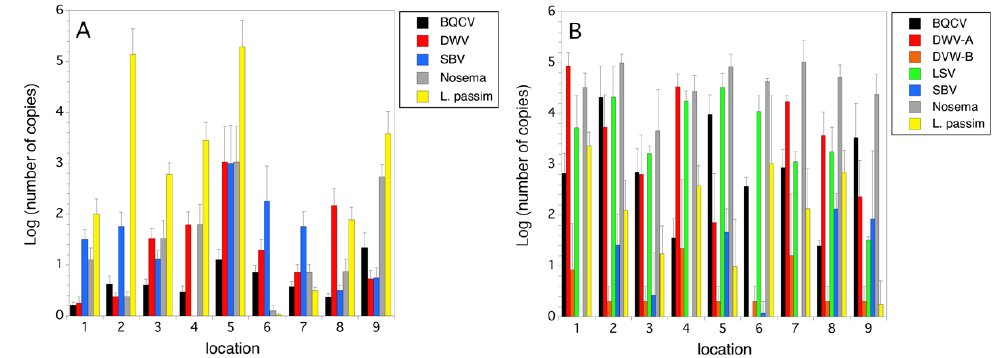
Figure 7. Pathogen incidence (logarithm base 10 (number of copies)) by hive location in 2014 ( A ) and 2015 ( B ). Error bars are standard errors.